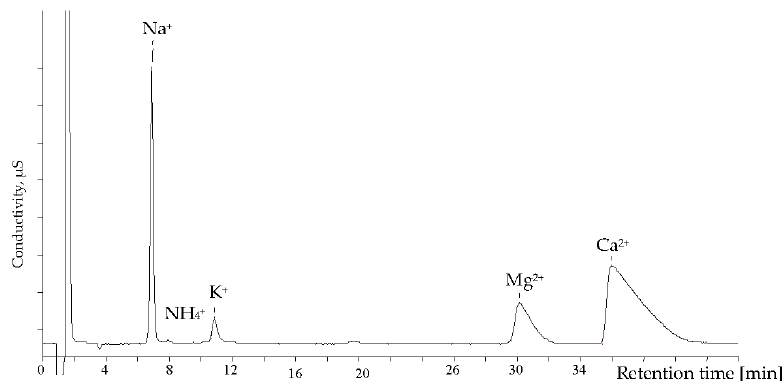
Figure 4. Chromatogram of cations in a municipal waste water sample. Separation conditions: analytical column: Metrohm Metrosep C2 (250 × 4.6 mm); eluent: 4 mM tartaric acid + 0.75 mM DPA; detection: non-suppressed conductivity.